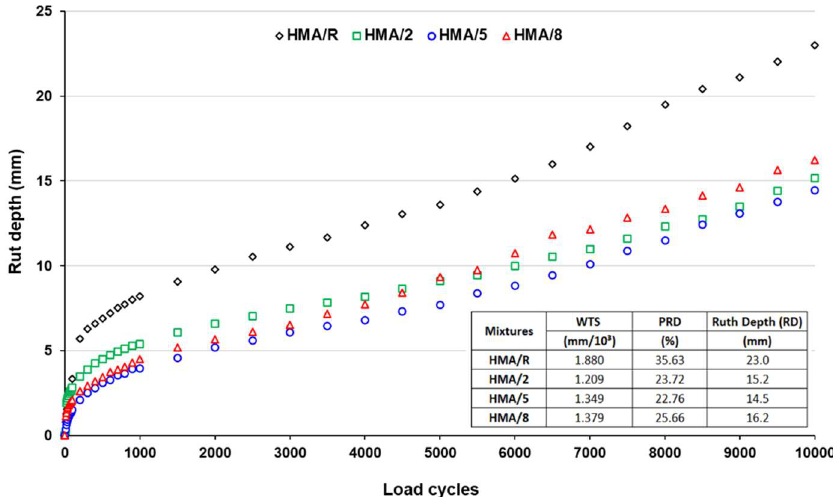
Figure 8. Hamburg Wheel Tracking Test results at 50 °C.